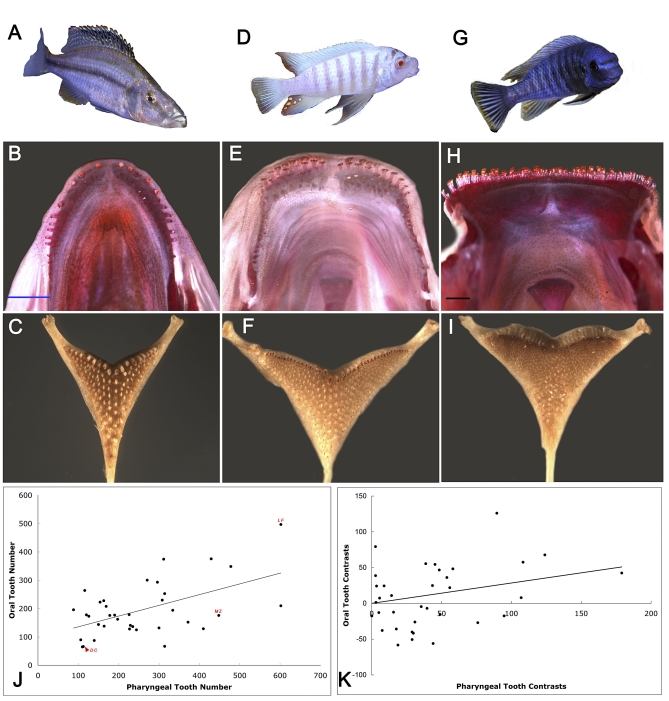
Oral and Pharyngeal Tooth Number Is Correlated in Malawi Cichlids(A–I) show three species of Malawi cichlid: D. compressiceps (DC) (A–C), M. zebra (MZ) (D–F), and L. fuelleborni (LF) (G–I). Dorsal views of (B, E, and H) show adult lower oral jaws, cleared and alizarin-stained bone/dentine preparation, and (C, F, and I) show adult lower (ceratobrachial [CB]5/PA7) pharyngeal jaws with the soft tissue removed. DC, MZ, and LF represent a range in oral and pharyngeal tooth number (Table S1): there are fewest teeth in DC, more teeth in MZ, many teeth in LF.(J) Across Malawi cichlids, a positive correlation is observed between the number of teeth on the oral and pharyngeal jaws (r = 0.53 without P. nigra and r = 0.66 including P. nigra; p < 0.00001), see (A–I). Data points labeled DC, MZ, and LF refer to the three species in (A–I).(K) Phylogenetically independent contrasts for tooth number across the Malawi cichlid flock without P. nigra (r = 0.39; p < 0.019; see Materials and Methods).Scale bars in (B) and (H) represent 500 μm. (E) and (H) are to the same scale. (C, F, and I) show the pharyngeal jaws to the same scale.